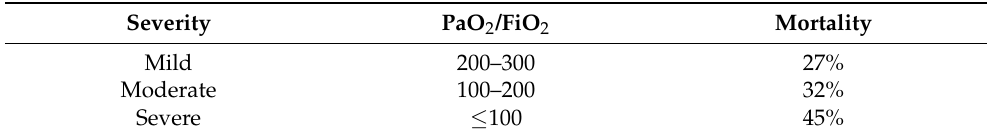
Table 1. ARDS severities in the Berlin definition and associated oxygenation levels and mortality rates